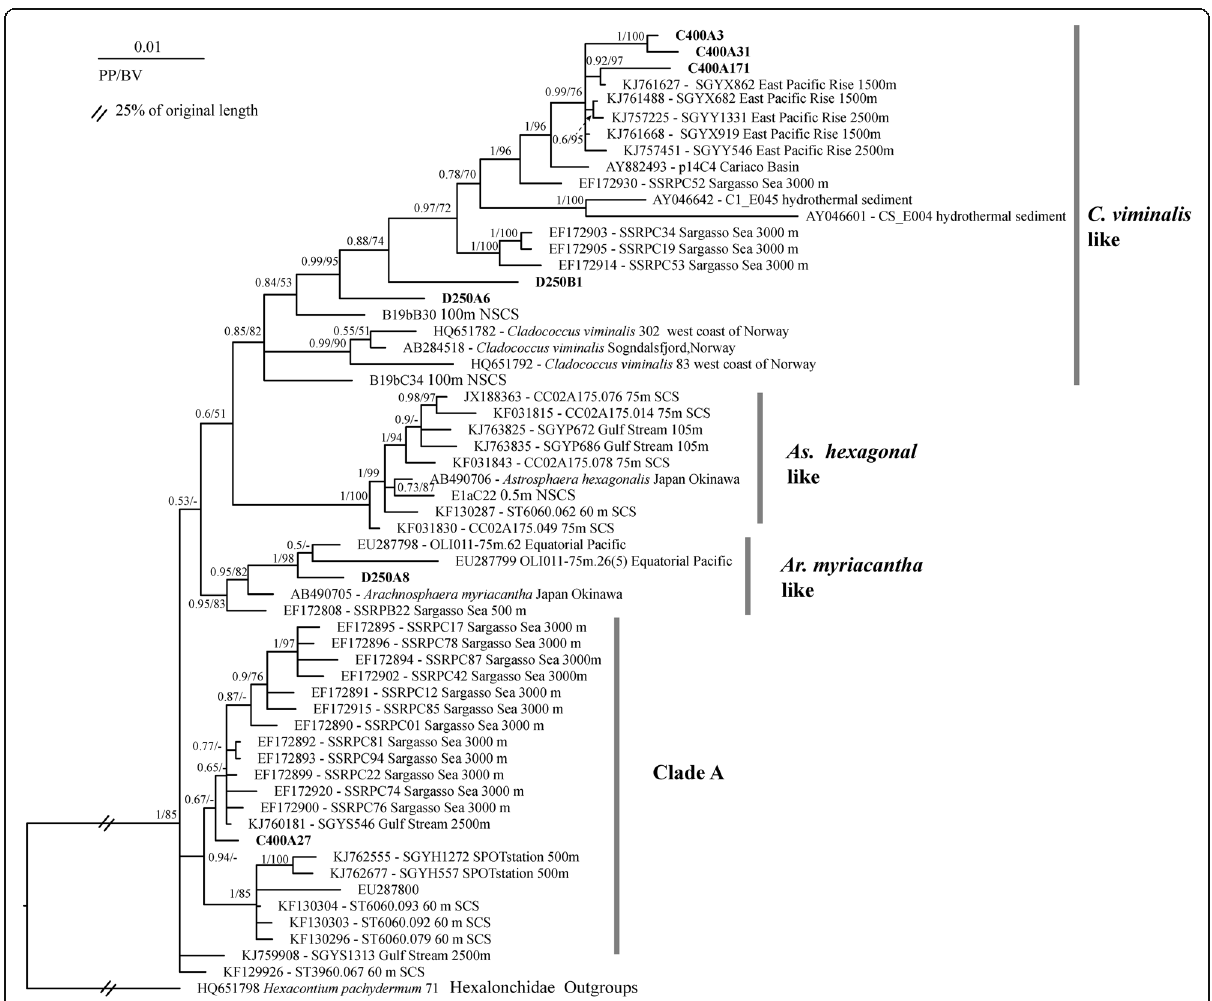
Fig. 4 A phylogenetic tree of RAD III based on 18S rDNA sequences. Sequences obtained from the Central Pacific Ocean in this study are in bold. Numbers at the nodes represent posterior probabilities (PP) of the Bayesian inferences, bootstrap values (BV) of the ML analysis. The scale bar in the upper left corner is the substitution rate per site for the Bayesian analyses. Sequences obtained in this study are shown in